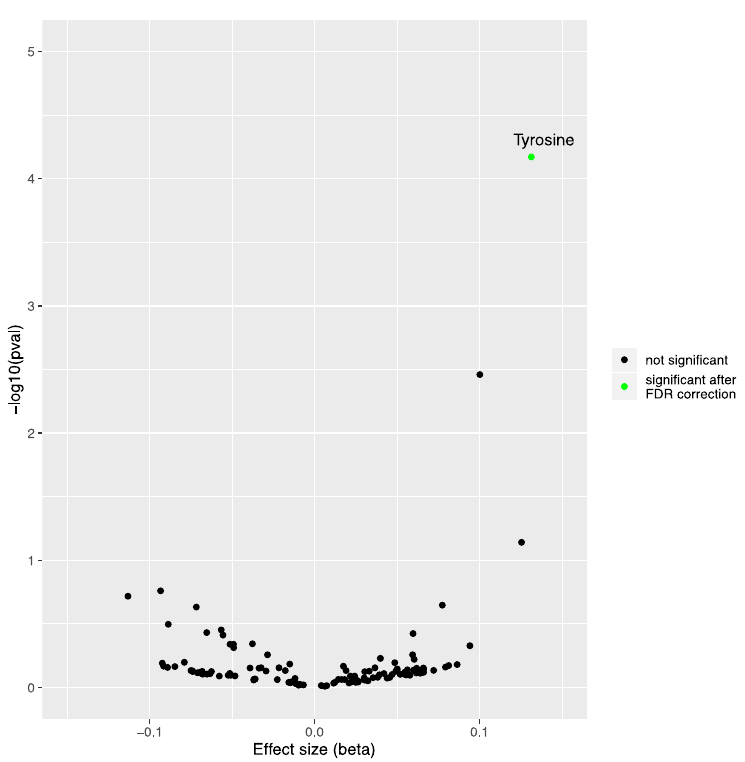
Figure 1. Causal impact of genetically predicted non-alcoholic fatty liver disease (NAFLD) using seven genome-wide significant SNPs on the blood metabolome. Volcano plot depicting the effect of genetically predicted NAFLD on blood metabolites ( n = 123) using inverse-variance weighted Mendelian randomization. Each dot represents a different metabolite, and the green dot represents the metabolite (here, tyrosine) significantly influenced by the presence of NAFLD following correction for false-discovery rate (pFDR < 0.05/123 metabolites).